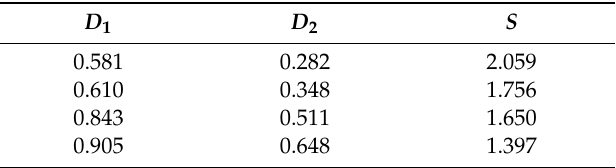
Table 3. Distribution coefficients and separation factors for the ternary system containing lactic acid (1), water (2) and AE (3): T = 308.15 K, P = 0.1 MPa (atmospheric pressure).